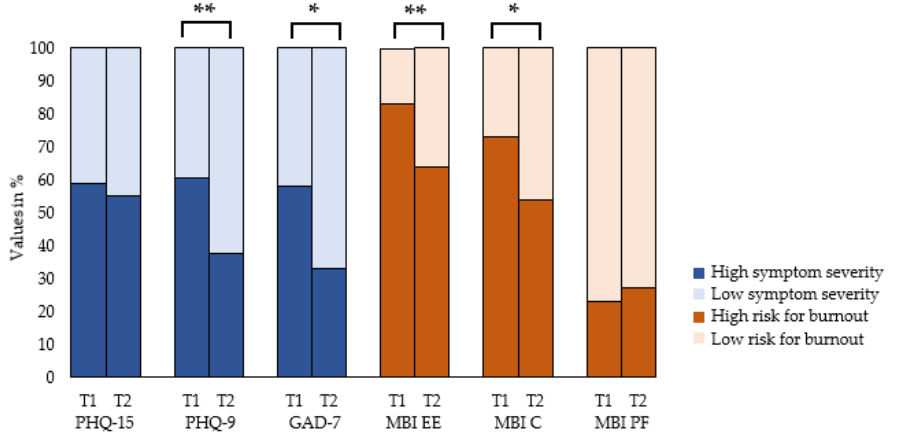
Figure 1. Symptom change from T1 to T2. PHQ-15 (Patient Health Questionnaire Somatization Module); PHQ-9 (Patient Health Questionnaire Depression Module); GAD-7 (General